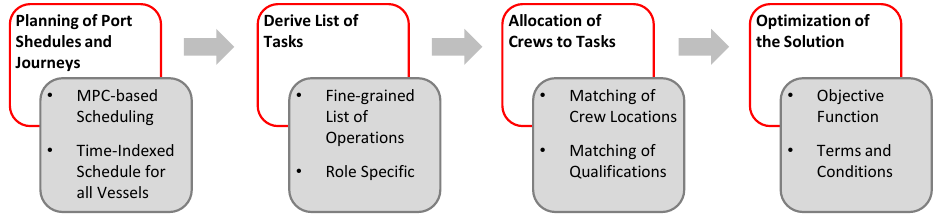
Figure 2. Crew Scheduling Procedure extended from Reference